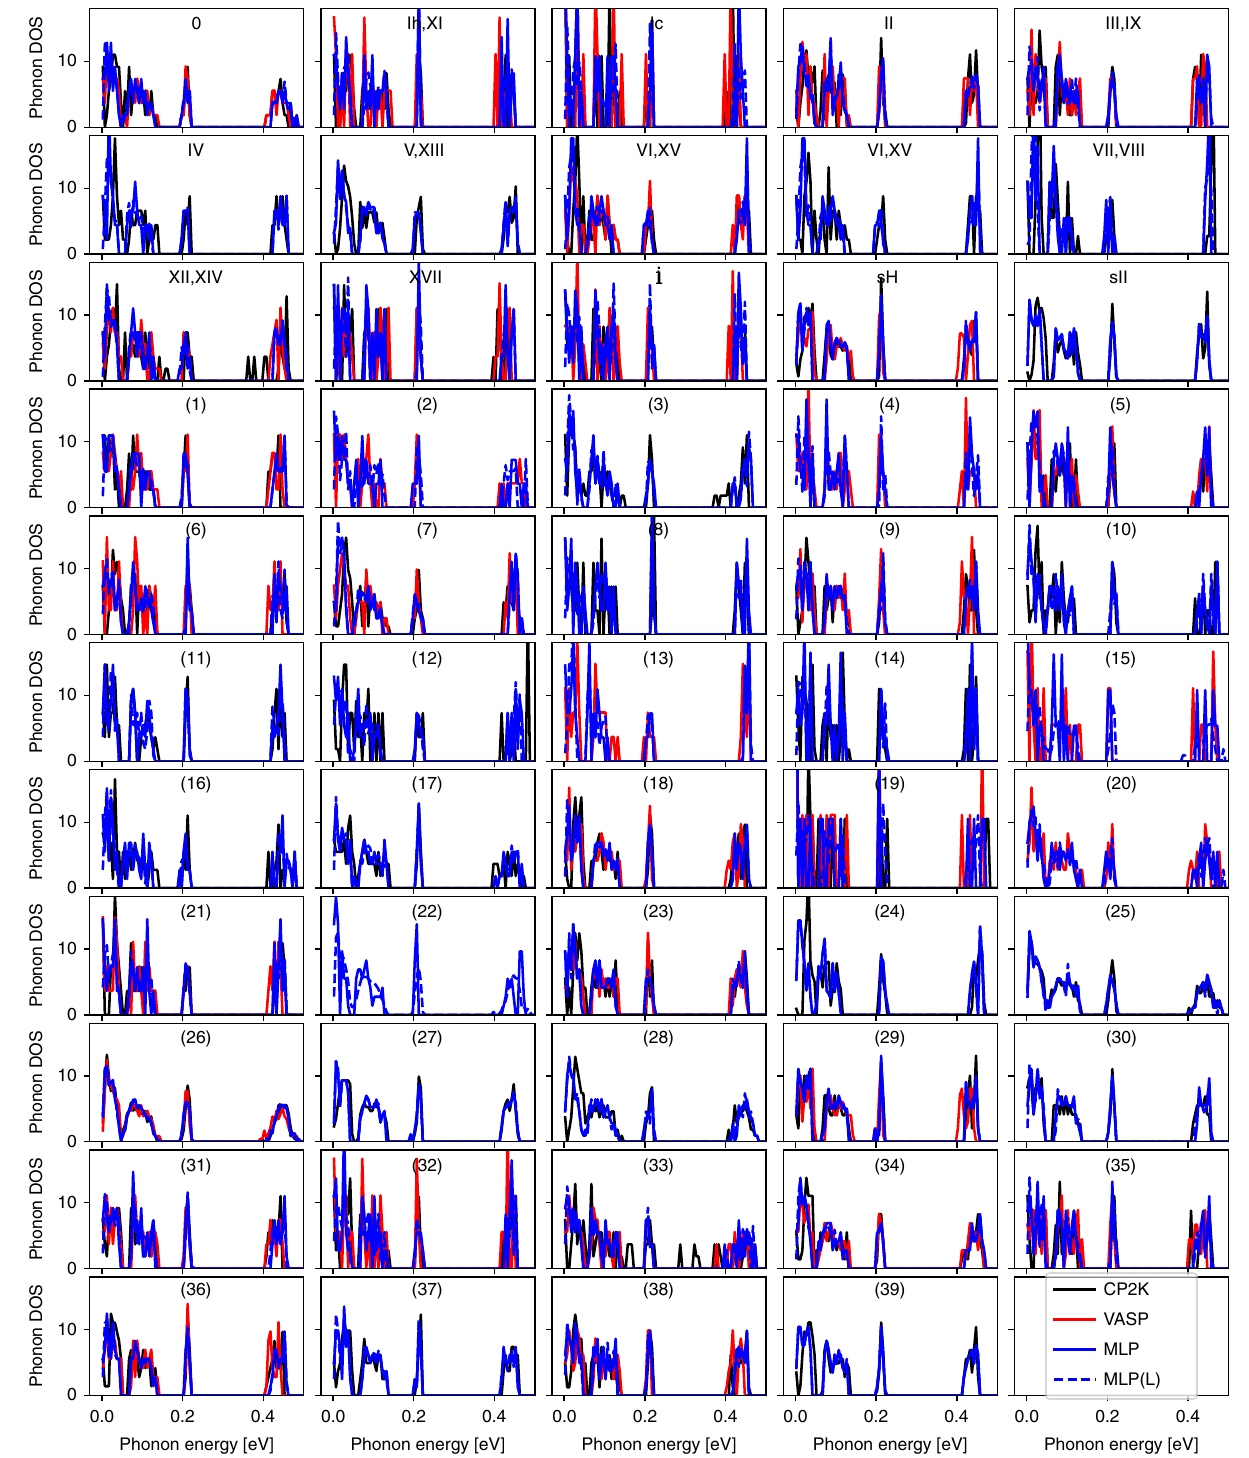
Fig. 5 A comparison between the phonon DOS at the Gamma point for 54 ice phases. The DOS were computed using revPBE0-D3 DFT calculations employing VASP , revPBE0-D3 DFT calculations employing CP 2 K , MLP using the original supercell, and MLP using replicated cell (MLP(L)). For the VASP and CP 2 K calculations, only those that exhibited no imaginary phonons are shown here. Source data are provided as a Source Data fi